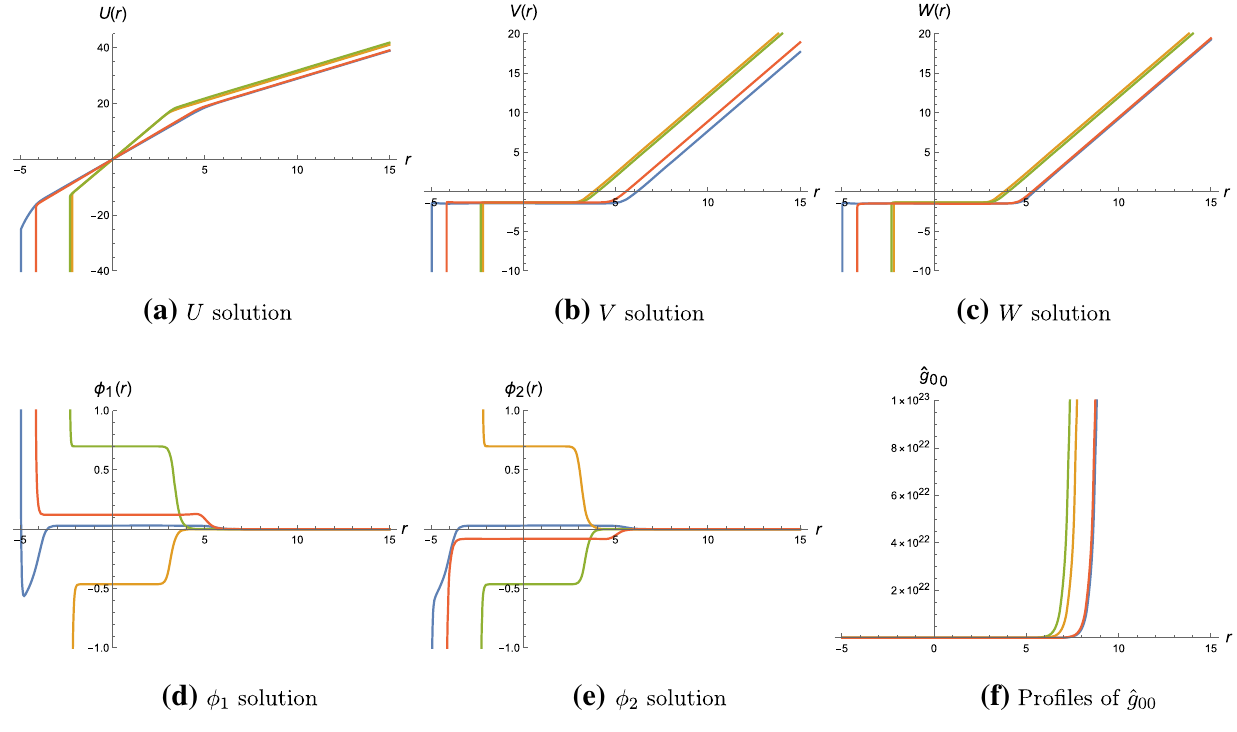
Fig. 14 RG flows from the N = 4 AdS 7 critical point to the AdS 3 × H 2 × H 2 fixed points and curved domain walls for SO ( 2 ) × SO ( 2 ) twist in SO ( 5 ) gauge group. The blue, orange, green and red curves refer to ( z 1 , z 2 ) = ( 0 , 0 ),( 0 . 3 , 0 . 3 ),( − 0 . 3 , − 0 . 3 ),( − 1 , 0 . 5 ) , respectively